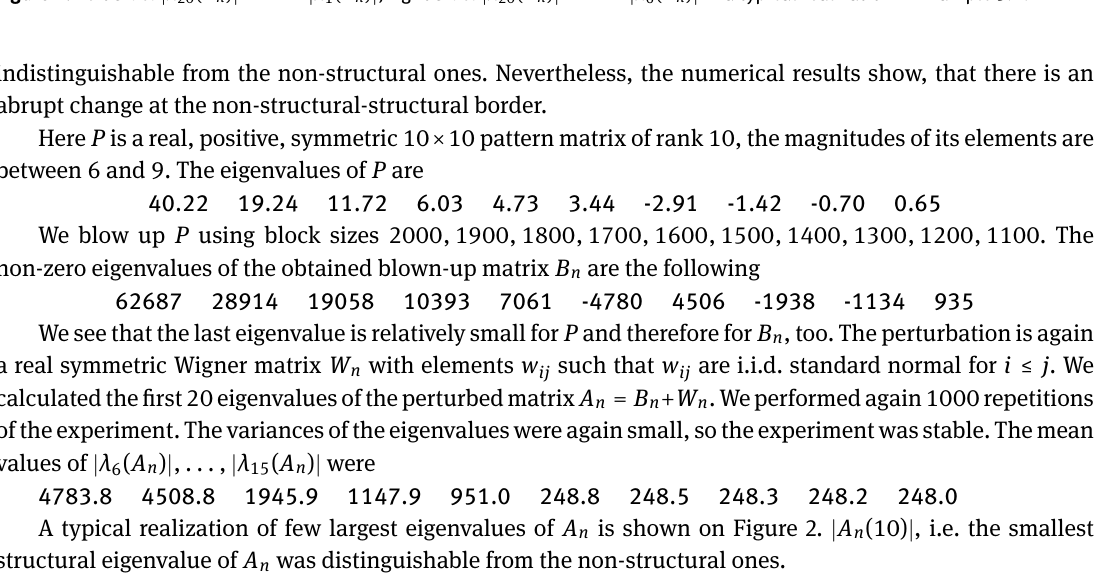
Figure 2: Left side: | λ 20 ( A n ) | < ··· < | λ 1 ( A n ) | ; right side: | λ 20 ( A n ) | < ··· < | λ 6 ( A n ) | in a typical realization in Example